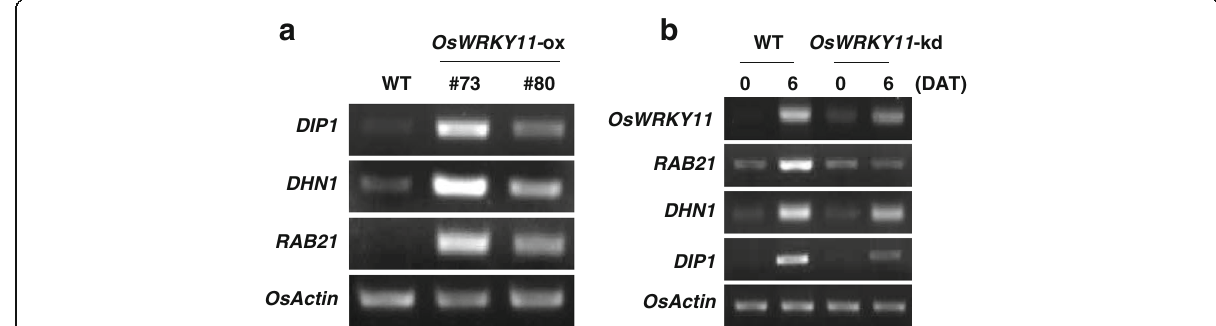
Fig. 5 RT-PCR analysis of expression of drought-responsive genes in OsWRKY11 -ox and OsWRKY11 -kd plants. a Total RNA was isolated from leaves of OsWRKY11 -ox plants from lines #73 and #80, and from WT controls. RT-PCR was performed using gene-specific primers against DIP1 , DHN1 , and RAB21 . b OsWRKY11 -kd and non-transgenic (WT) control plants were subjected to drought stress. Samples were collected 6 DAT. RT-PCR was performed using gene-specific primers against OsWRKY11 , RAB21 , DHN1 , and DIP1 . The transcript level of OsACTIN was used as an internal control. These experiments were repeated more than